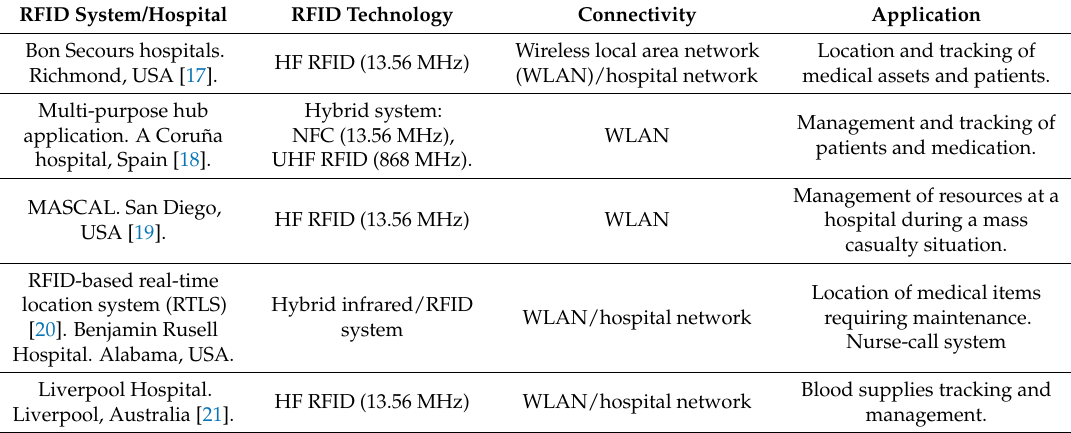
Table 2. Review of RFID-based systems for management and tracking in